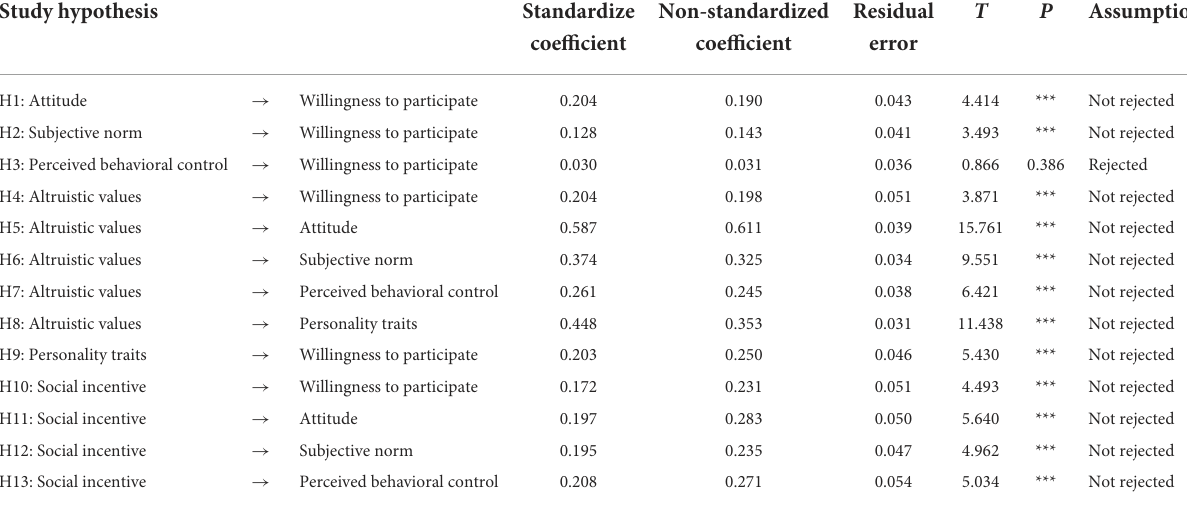
TABLE 6 Hypothesis testing of Willingness to participate in floating population health volunteer